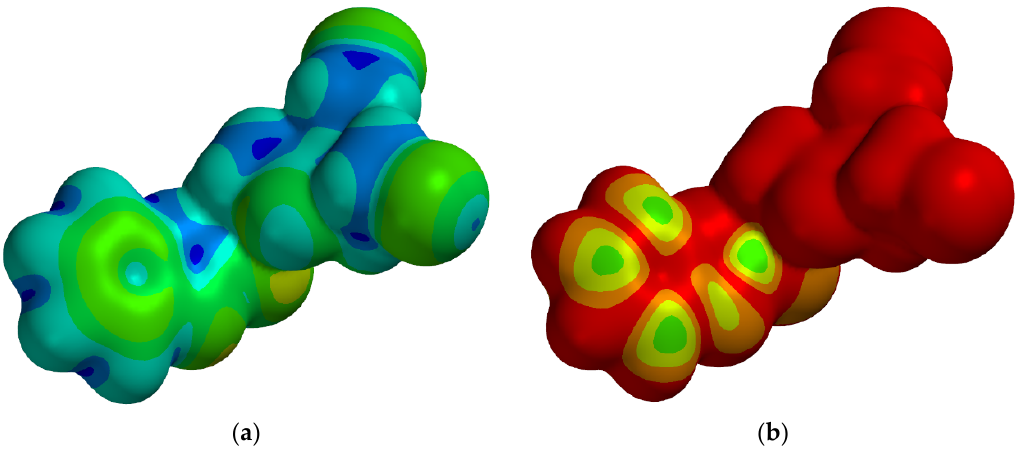
Figure 8. Local ionization map ( a ) and |LUMO| map ( b ) for molecule X. Some information can be extracted from the analysis of Figures